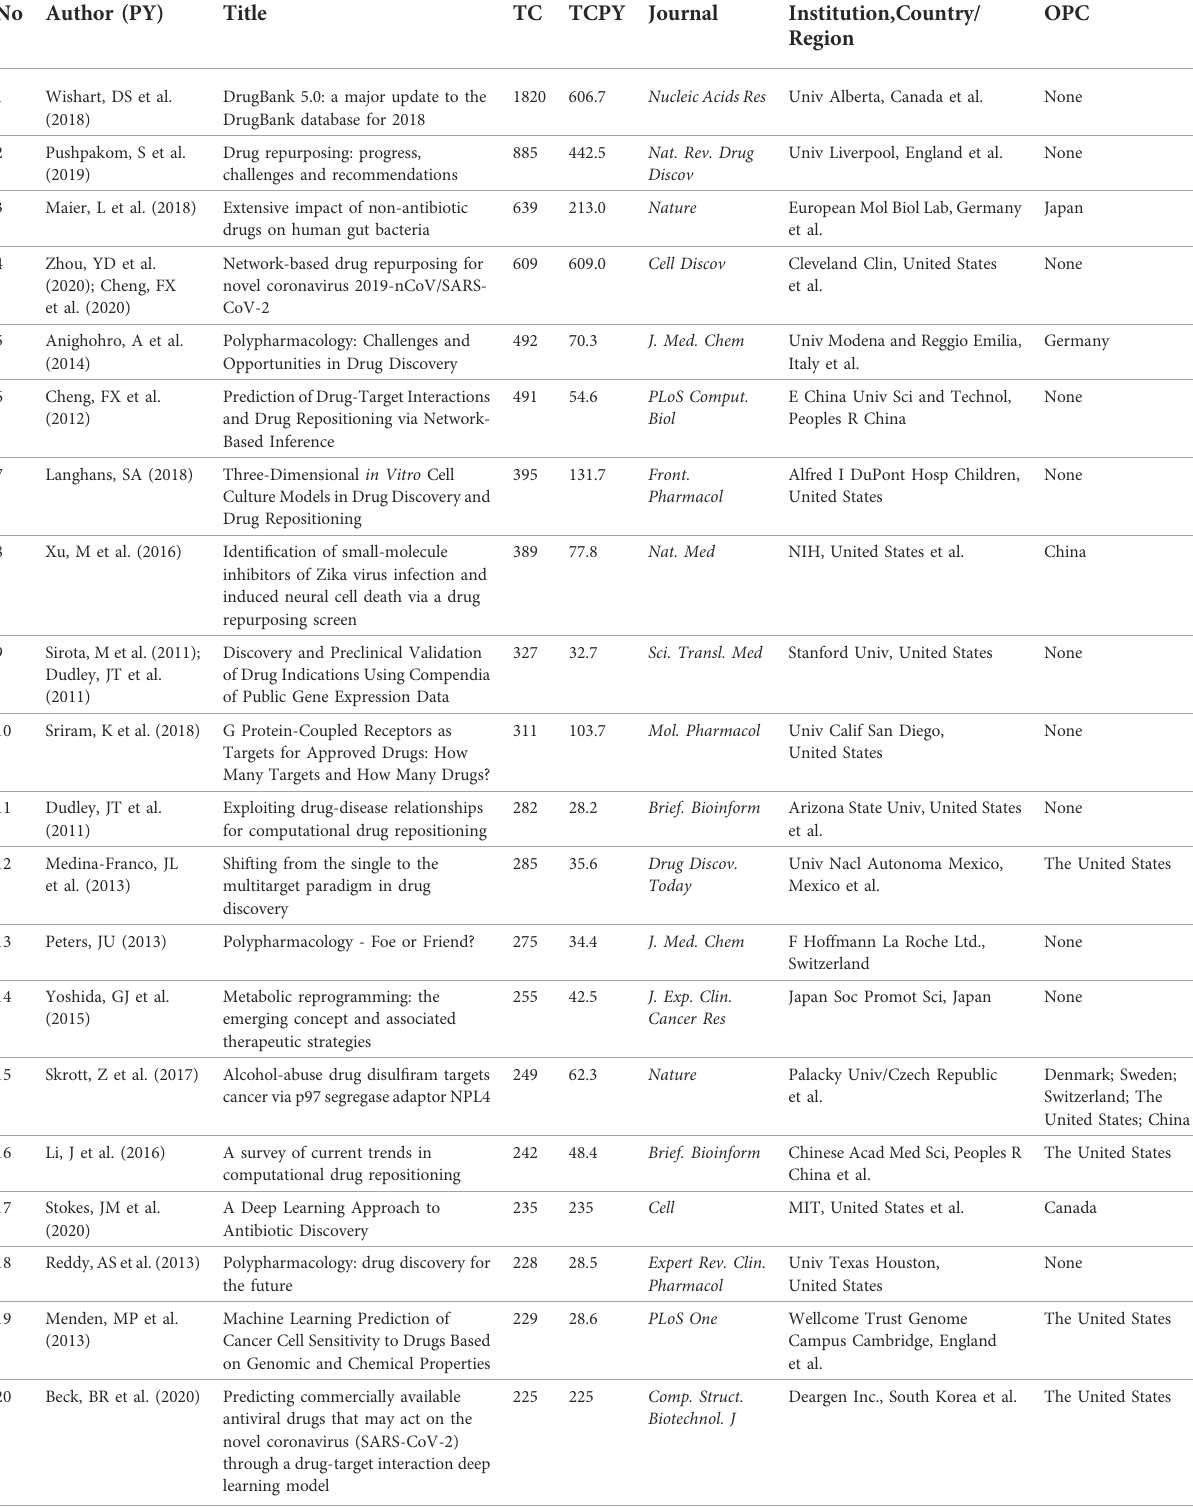
TABLE 7 Top 20 highly cited ESI publications from 2011 to